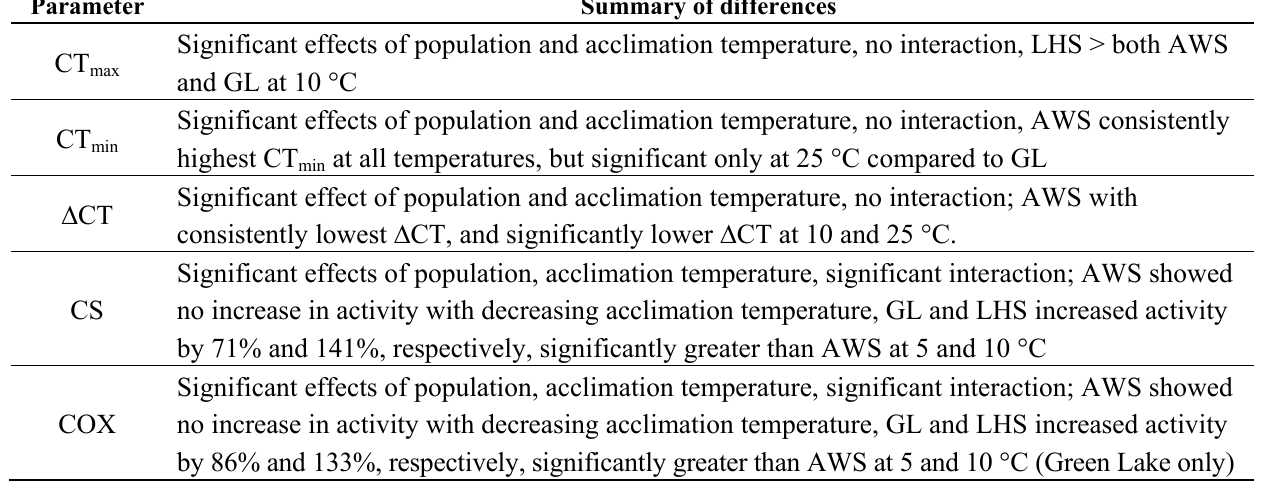
Table 1. Summary of main thermal physiological differences among three populations of wild-collected lake chub ( Couesius plumbeus ). See [14] for details. CT maximum water temperature at 5, 10, 20, 25 °C acclimation temperature, CT minimum water temperature at 5, 10, 20, 25 °C acclimation temperature,  CT = thermal breadth (CT - CT ) at 5, 10, 20, 25 °C acclimation temperature, CS = citrate synthase max min activity at 5, 10, 20, and 25 °C acclimation temperature, COX = cytochrome oxidase activity at 5, 10, 20, and 25 °C acclimation temperature, LDH = lactate dehydrogenase activity at 5, 10, 20, and 25 °C acclimation temperature, PK = pyruvate kinase activity at 5, 10, 20, and 25 °C acclimation temperature, PC, axial muscle protein content at 5, 10, 20, and 25 °C acclimation temperature. AWS = Atlin Warmspring, LHS = Liard Hotsprings, GL = Green